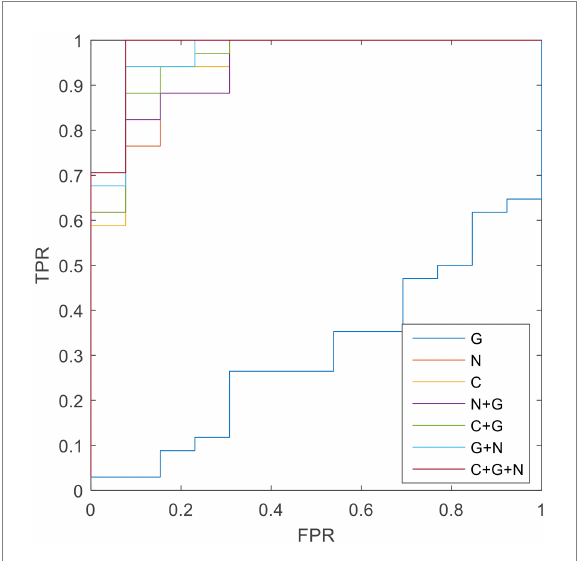
FIGURE 2 The ROC results of different methods.